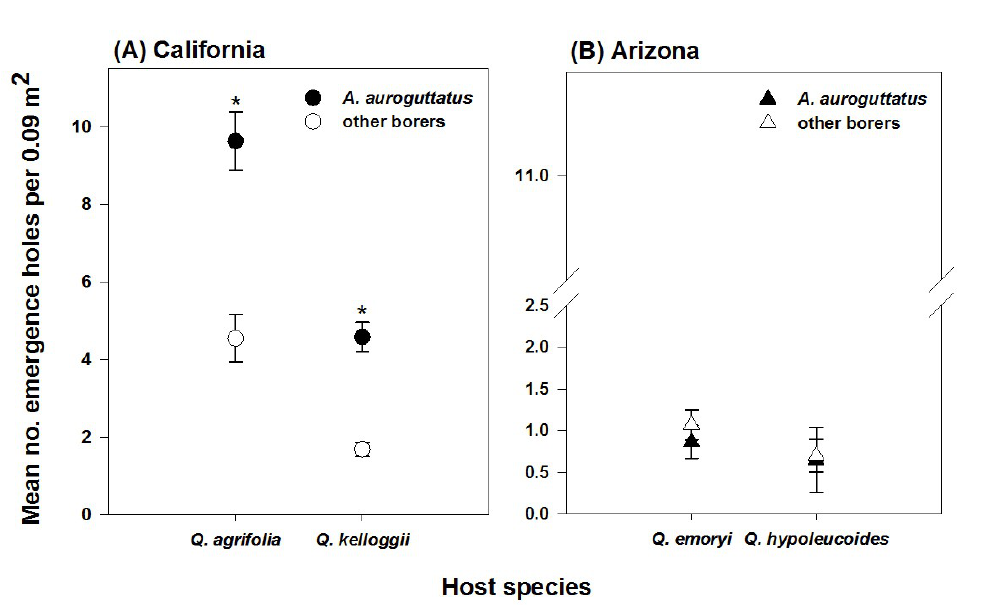
sites ( Q. emoryi ); and 33 trees across three sites ( Q. hypoleucoides